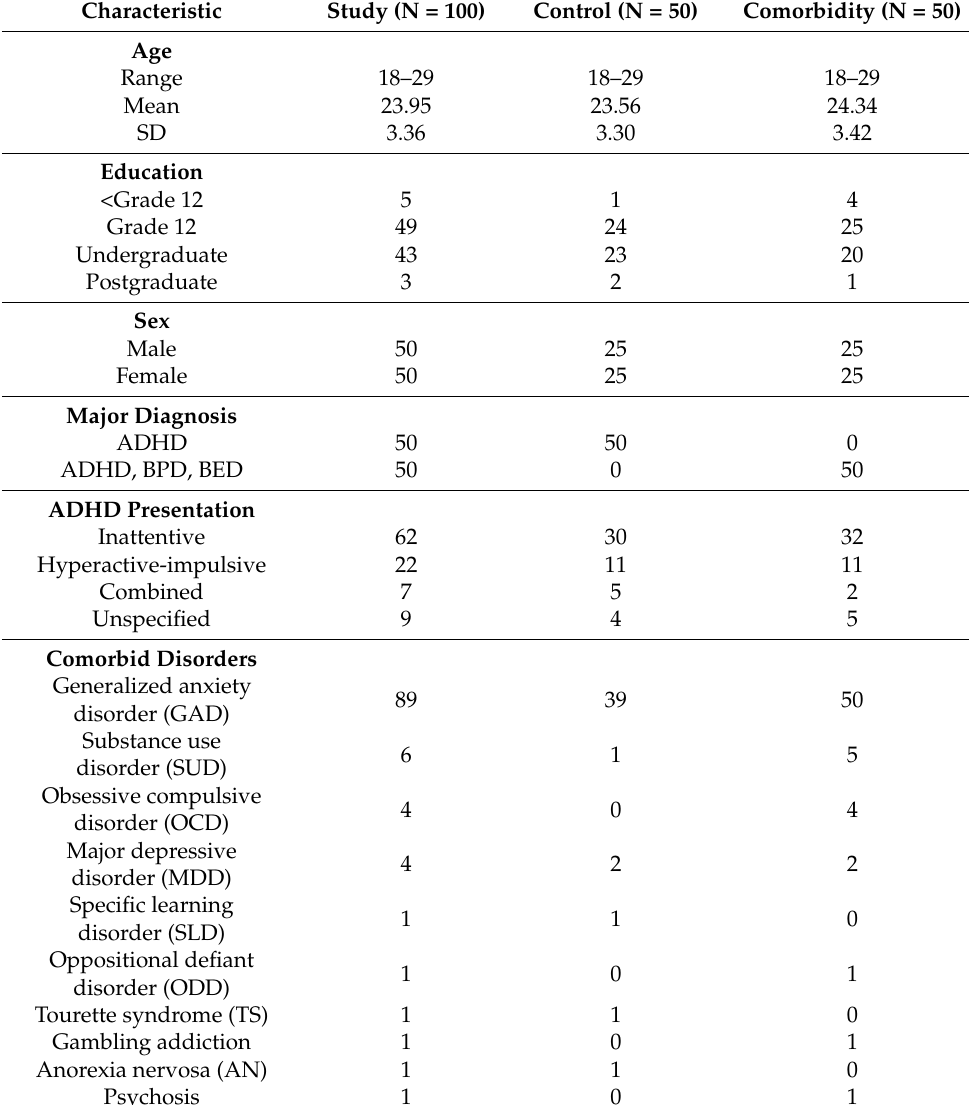
Table 1. Sociodemographic and diagnostic characteristics of the study sample (N =